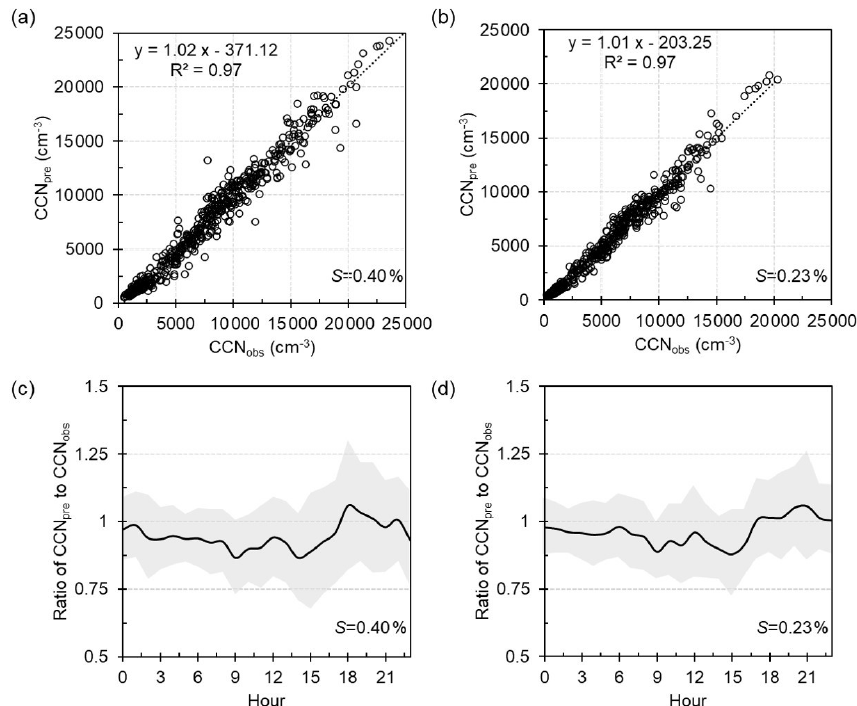
Figure 7. Predicted CCN number concentration using the mixing state and In-BC density derived from HTDMAs at S = 0 . 40% (a) and S = 0 . 23% (b) . Diurnal variations in the ratio of predicted-to-measured N CCN at S = 0 . 40% (c) and S = 0 . 23% (d) are